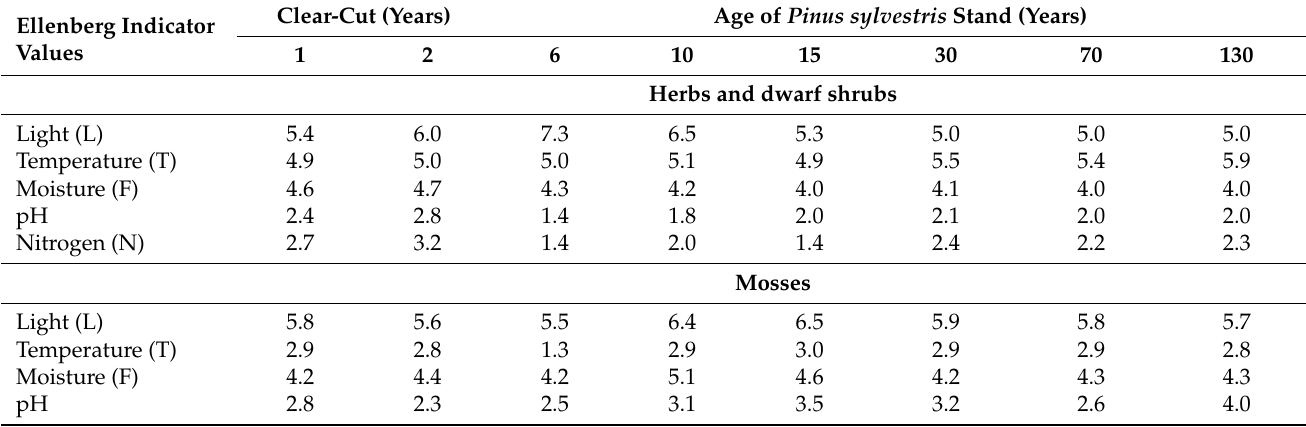
Table 4. Ellenberg indicator values for the ground vegetation species at different Pinus sylvestris sites, including 1–2-year-old clear-cuts and 6–130 years old stands.